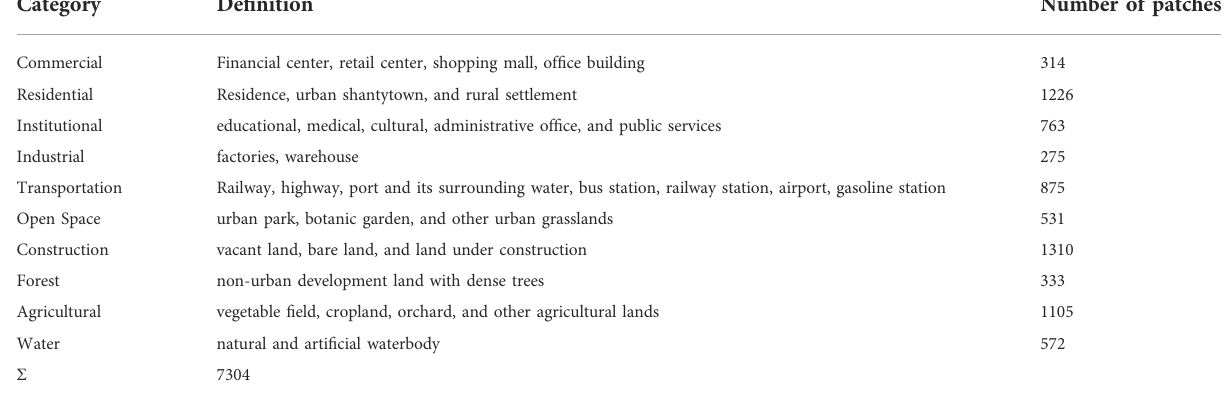
TABLE 1 The classi fi cation system and number of patches for each UFZ type of the collected dataset.